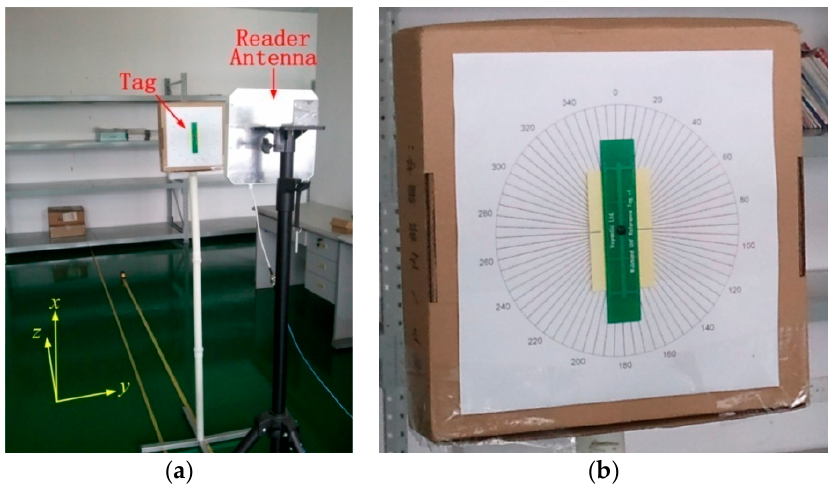
Figure 5. Experimental measurement: ( a ) Test setup. ( b ) Markers illustrating the tag orientation.